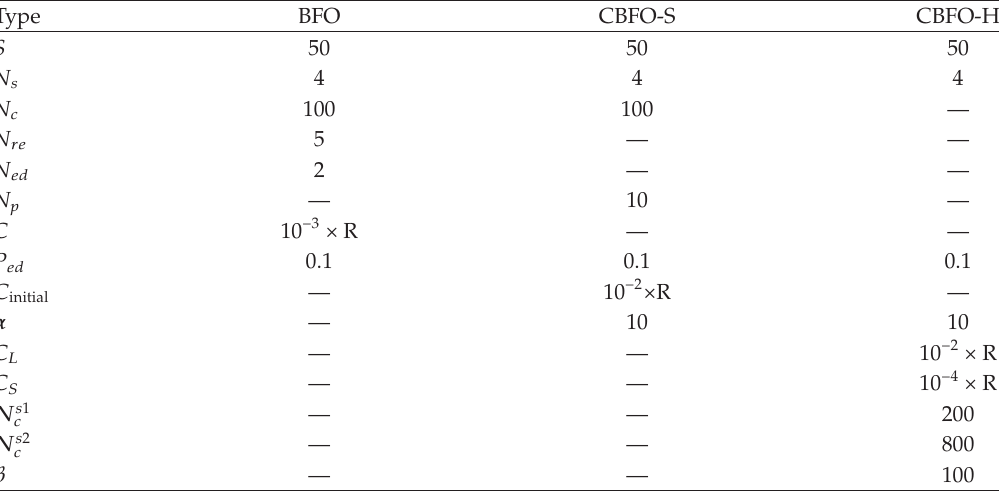
Table 2: Parameters of the BFO algorithms.